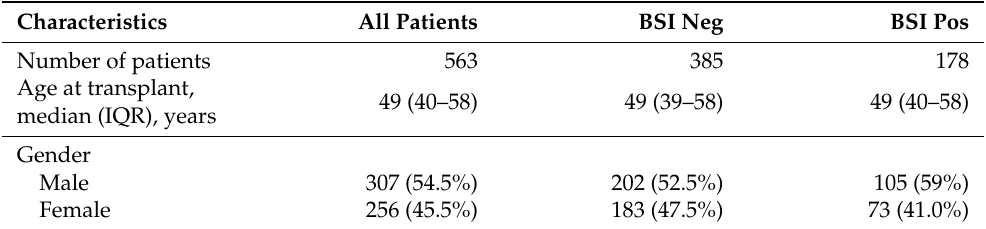
Table 1. Main patients’ and transplants’ characteristics of the whole cohort and stratified by BSI.